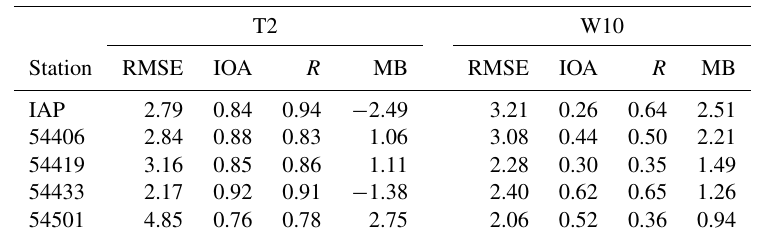
Table 3. Values of statistical parameters measuring the model performance when simulating the 2m temperature (T2) and the 10m wind speed (W10) at five observation stations. T2 W10 Station RMSE IOA R MB RMSE IOA R MB